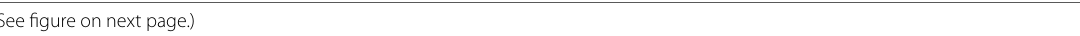
figure on next Fig. 5 The wound healing effect of beta-glucans in an in vivo excisional model. a , b Wound closure in an excisional wound model for 14 days. Photos were taken every 3 days and wound area was measured using the ImageJ program. ‘Madecassol’ was used as a positive control. c The number of scab loss at day 8 after wounding. The number of scab uncombined mouse were counted and quantifiably shown as a graph (n each group). d Hematoxylin and eosin staining of skin tissue isolated from the wound site on day 7. The photographs were acquired at magnification using a microscope. Re-epithelialization was measured using the ImageJ program and showed as a graph. Dotted line; a boundary line of wound site, GT granulation tissue. *P < 0.05 as compared to the